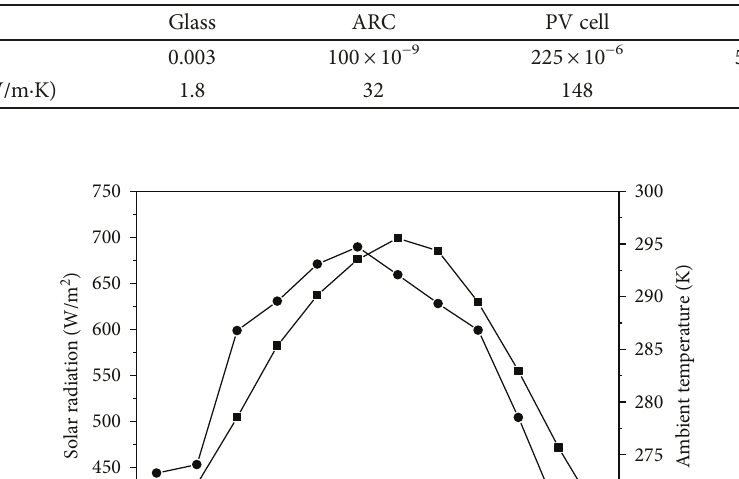
Table 3: Photovoltaic layer properties.